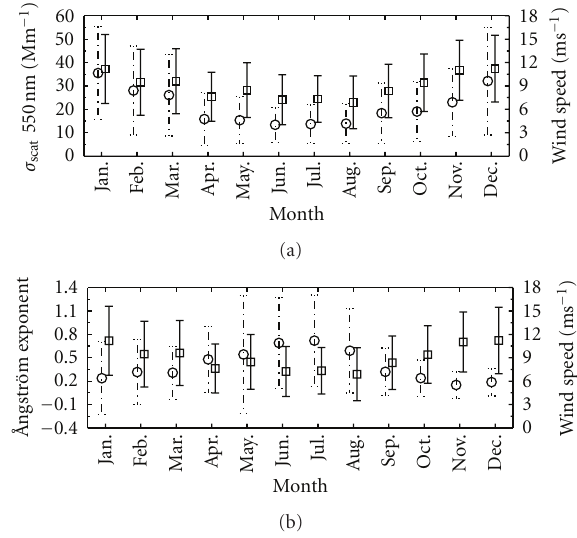
Figure 4: Seasonal variation of the (a) σ scat (circle) and wind speed (square), (b) ˚A (circle) and wind speed (square). The standard deviation associated with each datapoint is plotted as a dashed vertical bar for the σ scat and the ˚A and as a solid vertical bar for the wind speed. σ scat , ˚A, and wind speed are averaged over a period of 10 years from June, 2001 to December, 2010.